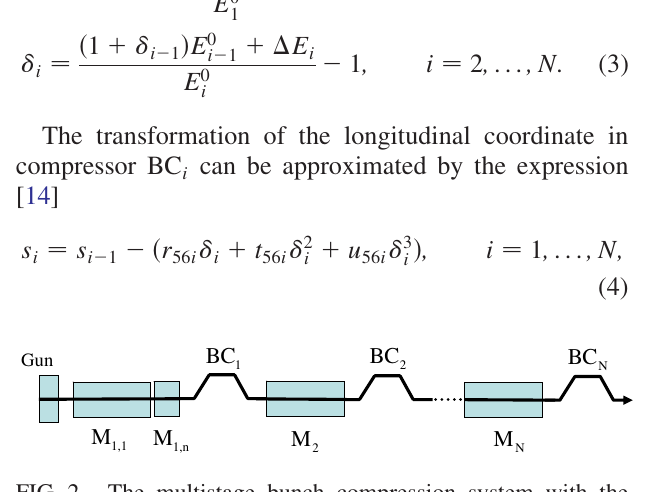
FIG. 2. The multistage bunch compression system with the high harmonic module at the first